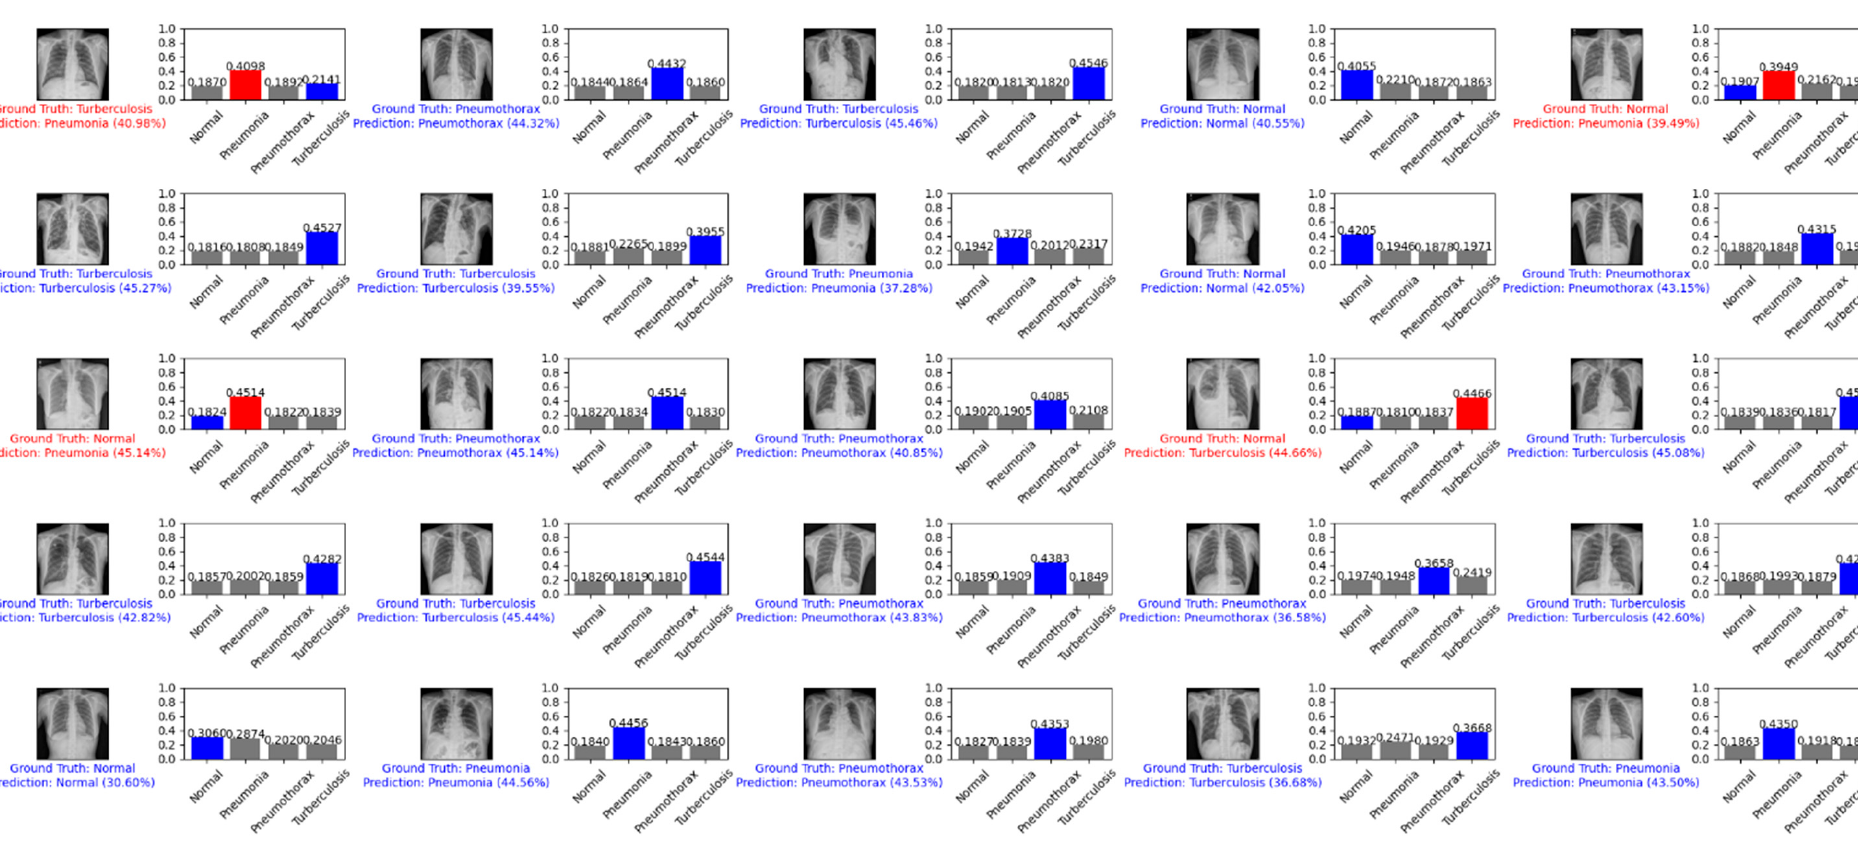
Figure 13. Example predictions for the normal, pneumonia, pneumothorax, and tuberculosis classes of the testing set of the SCH data set: ( a ) the first 25 images of the normal class; ( b ) 25 random images.